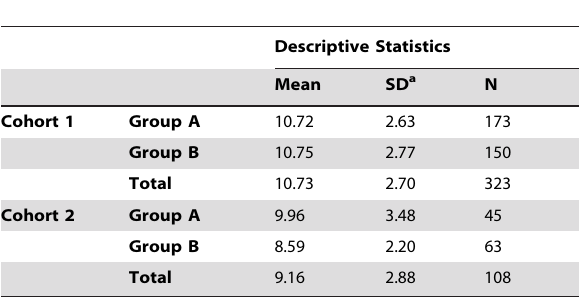
Table 4. Cohort Group Comparison of Post-Test Composite Mean